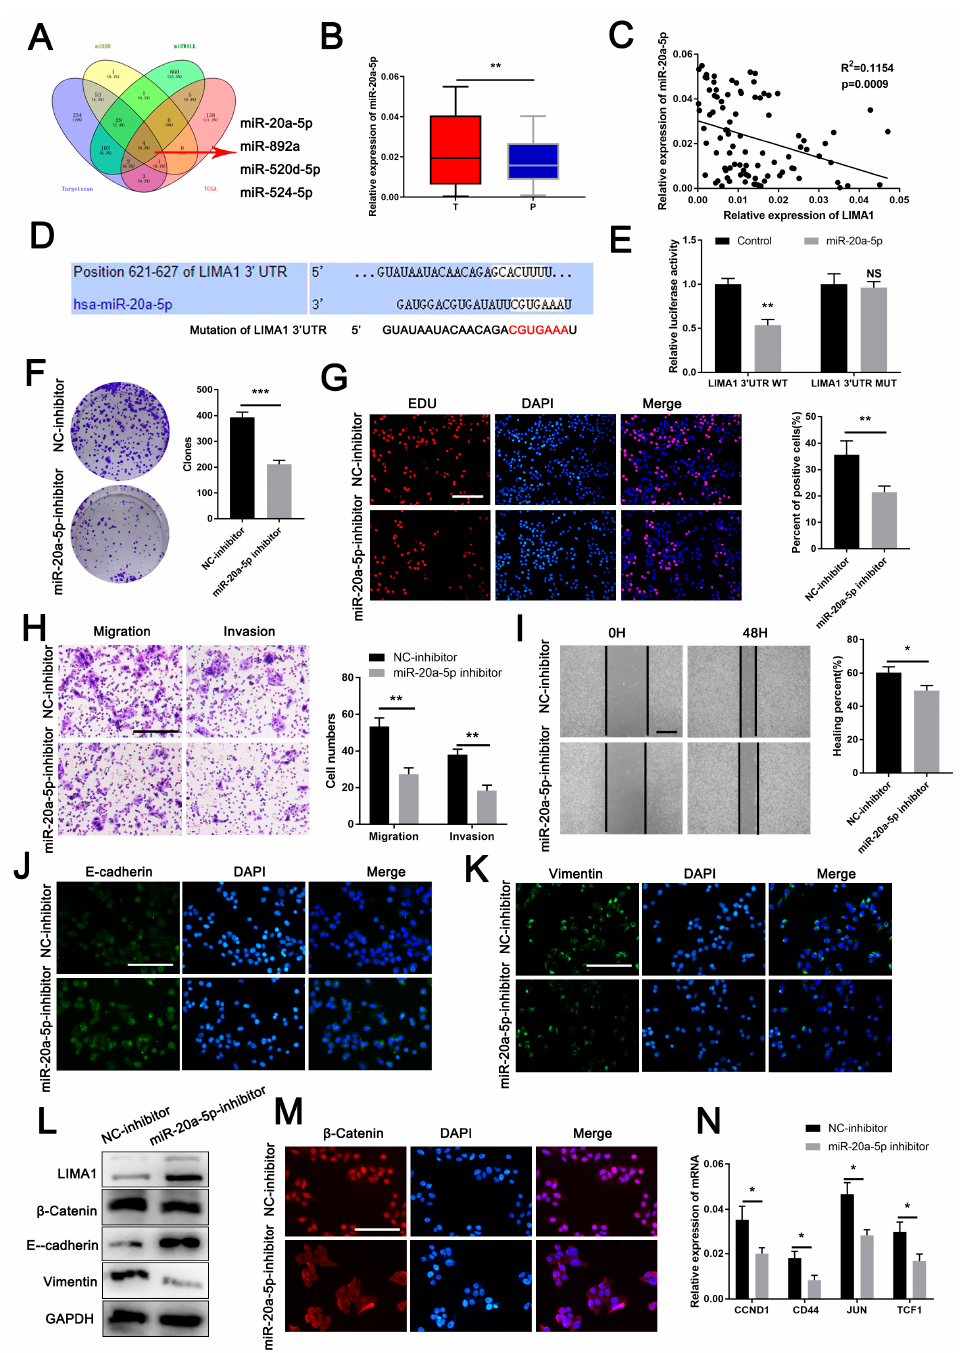
Figure 5. MiR-20a-5p is an oncogene targeting LIMA1. ( A ) The upstream miRNAs targeting LIMA1 were predicted based on the TargetScan, miRDB, miRALK and TCGA databases. ( B ) The expression level of miR-20a-5p in HCC tissues and ( C ) its correlation with LIMA1 were analysed. ( D ) The binding site between miR-20a-5p and LIMA1 was predicted by TargetScan, and the mutated site was constructed. ( E ) A dual luciferase reporter assay was performed to verify the target relationship between miR-20a-5p and LIMA1. ( F ) Colony formation and ( G ) EdU assays were performed to detect the effects of miR-20a-5p on proliferation. ( H ) Transwell and wound healing assays ( I ) were performed to examine the effects of miR-20a-5p on invasion and migration. Immunofluorescence for E-cadherin ( J ) and vimentin ( K ) and western blotting ( L ) for LIMA1, β -catenin, vimentin and E-cadherin were performed to detect the role of miR-20a-5p in EMT progression. ( M , N ) The translocation of β -catenin was examined by immunofluorescence, and the downstream molecules were examined by RT-qPCR. * p < 0.05, ** p <